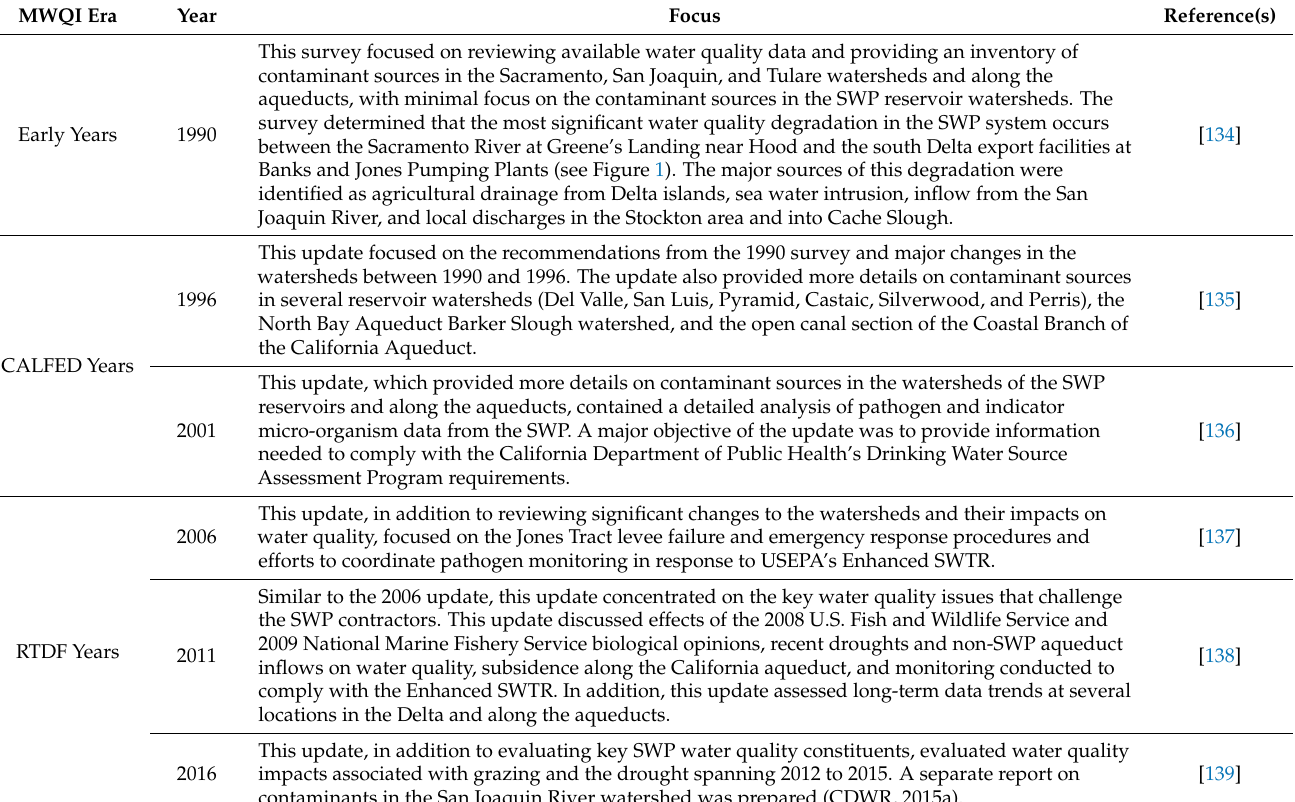
Figure A4. Sacramento River at Hood Real ‐ Time Monitoring Station.